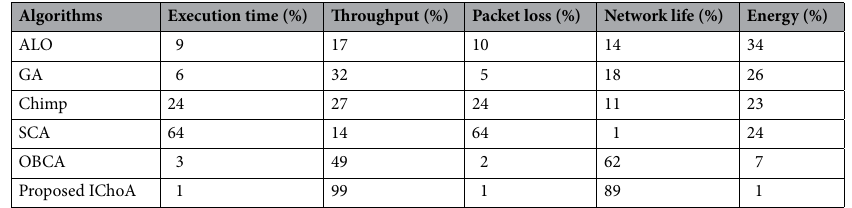
Table 13. Performance evaluation of various optimization algorithms for wireless sensor network